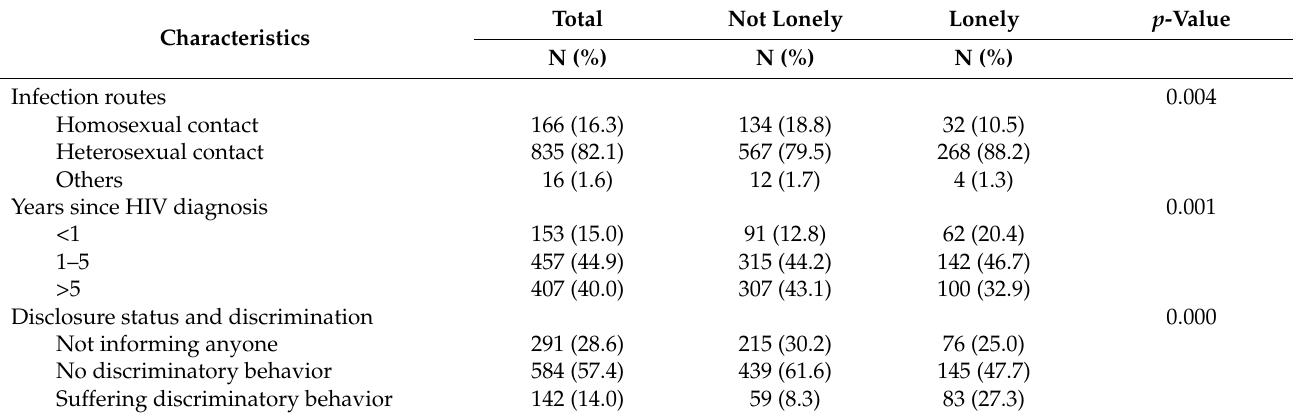
Table 2. HIV-related characteristics of